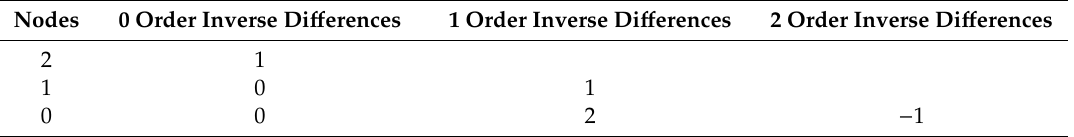
Table 4. Table of inverse di ff erences.